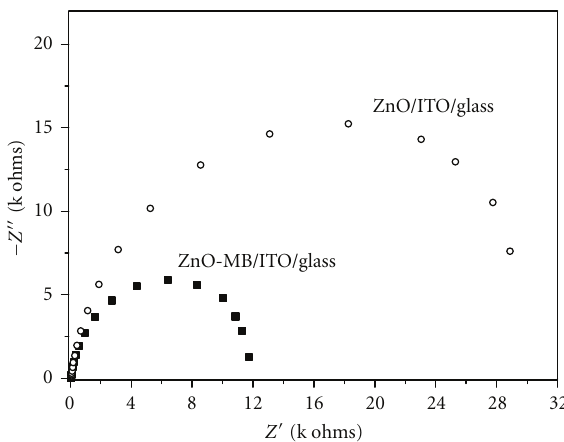
Figure 3: Impedance spectra of the pure ZnO and composite ZnO- MB thin